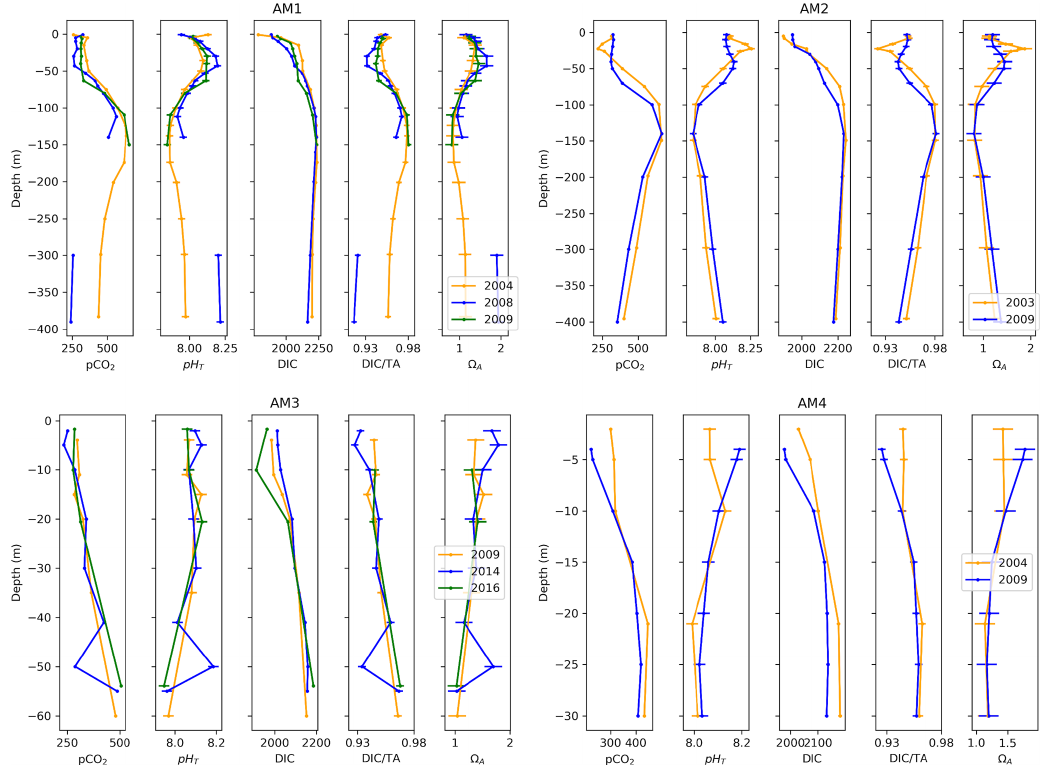
Figure 11. Depth profiles of p CO 2 , pH T , DIC, DIC /T A and (cid:127) A and uncertainties across time at four locations at the western limit of the Amundsen Gulf (AM1, 2, 3,